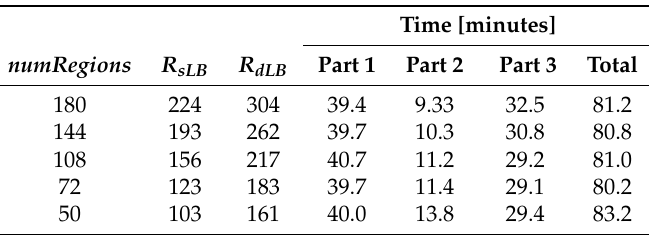
Table 1. Impact of the user requested number of the regions ( numRegions ) on the actual number of regions generated during static ( R sLB ) and dynamic ( R dLB ) load balancing, in addition to the resulting total computation time of the pipeline and that of Parts 1 to 3 (single-node performance).